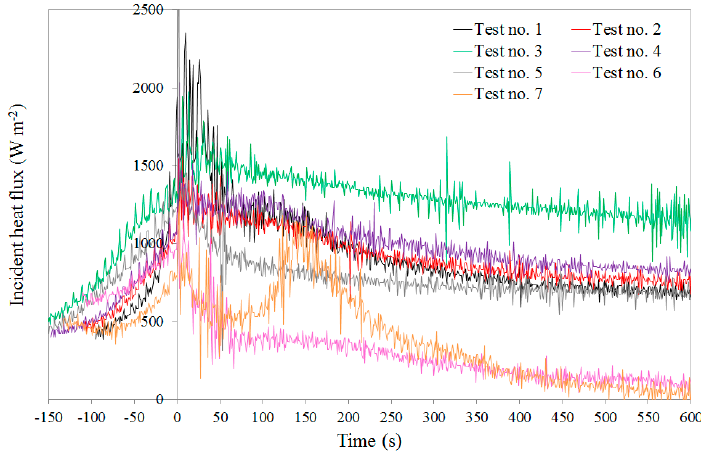
Figure 13. Incident heat-flux trend for all the conducted tests.